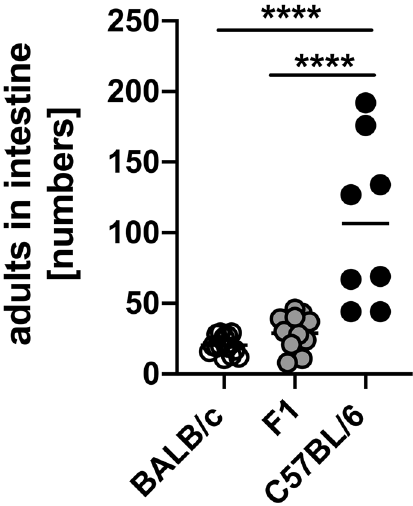
Figure 1. F1 mice have lower numbers of adults in the intestine than C57BL/6 mice . BALB/c, F1 and C57BL/6 mice were infected with 2000 iL3 s.c. in the footpad. Parasitic adults in the small intestine were counted at day 6 p.i. Shown are combined results from 2–3 experiments (BALB/c: n = 14 mice, F1: n = 13 mice and C57BL/6: n = 8 mice). Each symbol represents the worm burden from a single mouse. Horizontal lines represent the mean. Data were analyzed by 1-way ANOVA with Tukey’s multiple comparisons test. Asterisks indicate significant differences of the mean (****p ≤